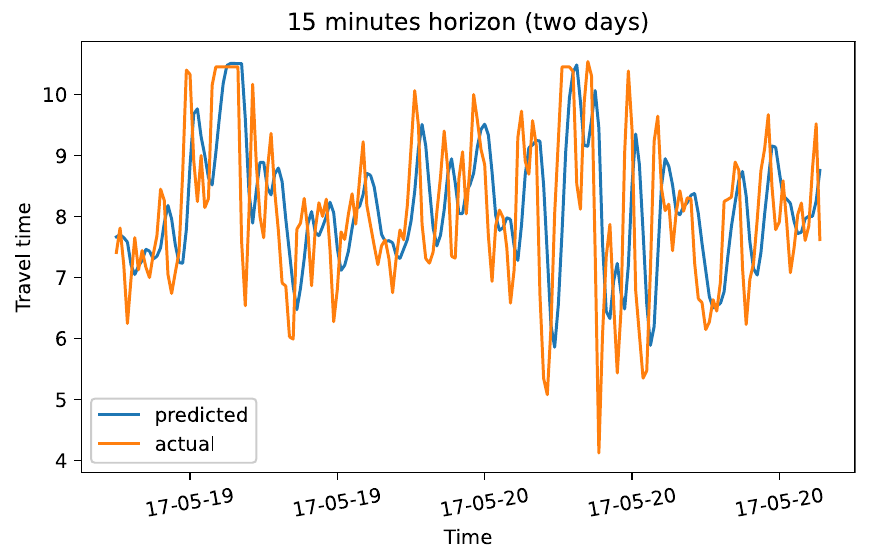
Fig 7. Prediction results for 15 minutes horizon on test data (two days).